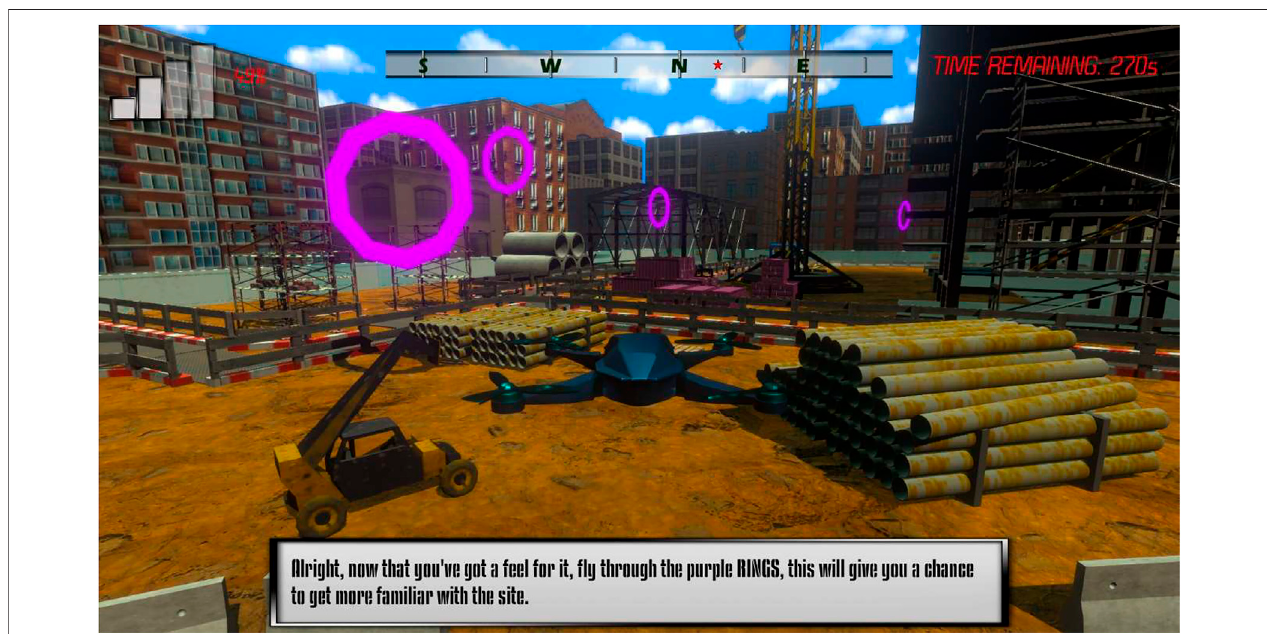
FIGURE 1 | Screenshot of tutorial hoops the player must pilot the drone through to learn the drone controls.